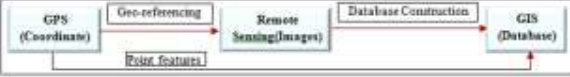
Figure 3. Integration of GPS, RS and GIS